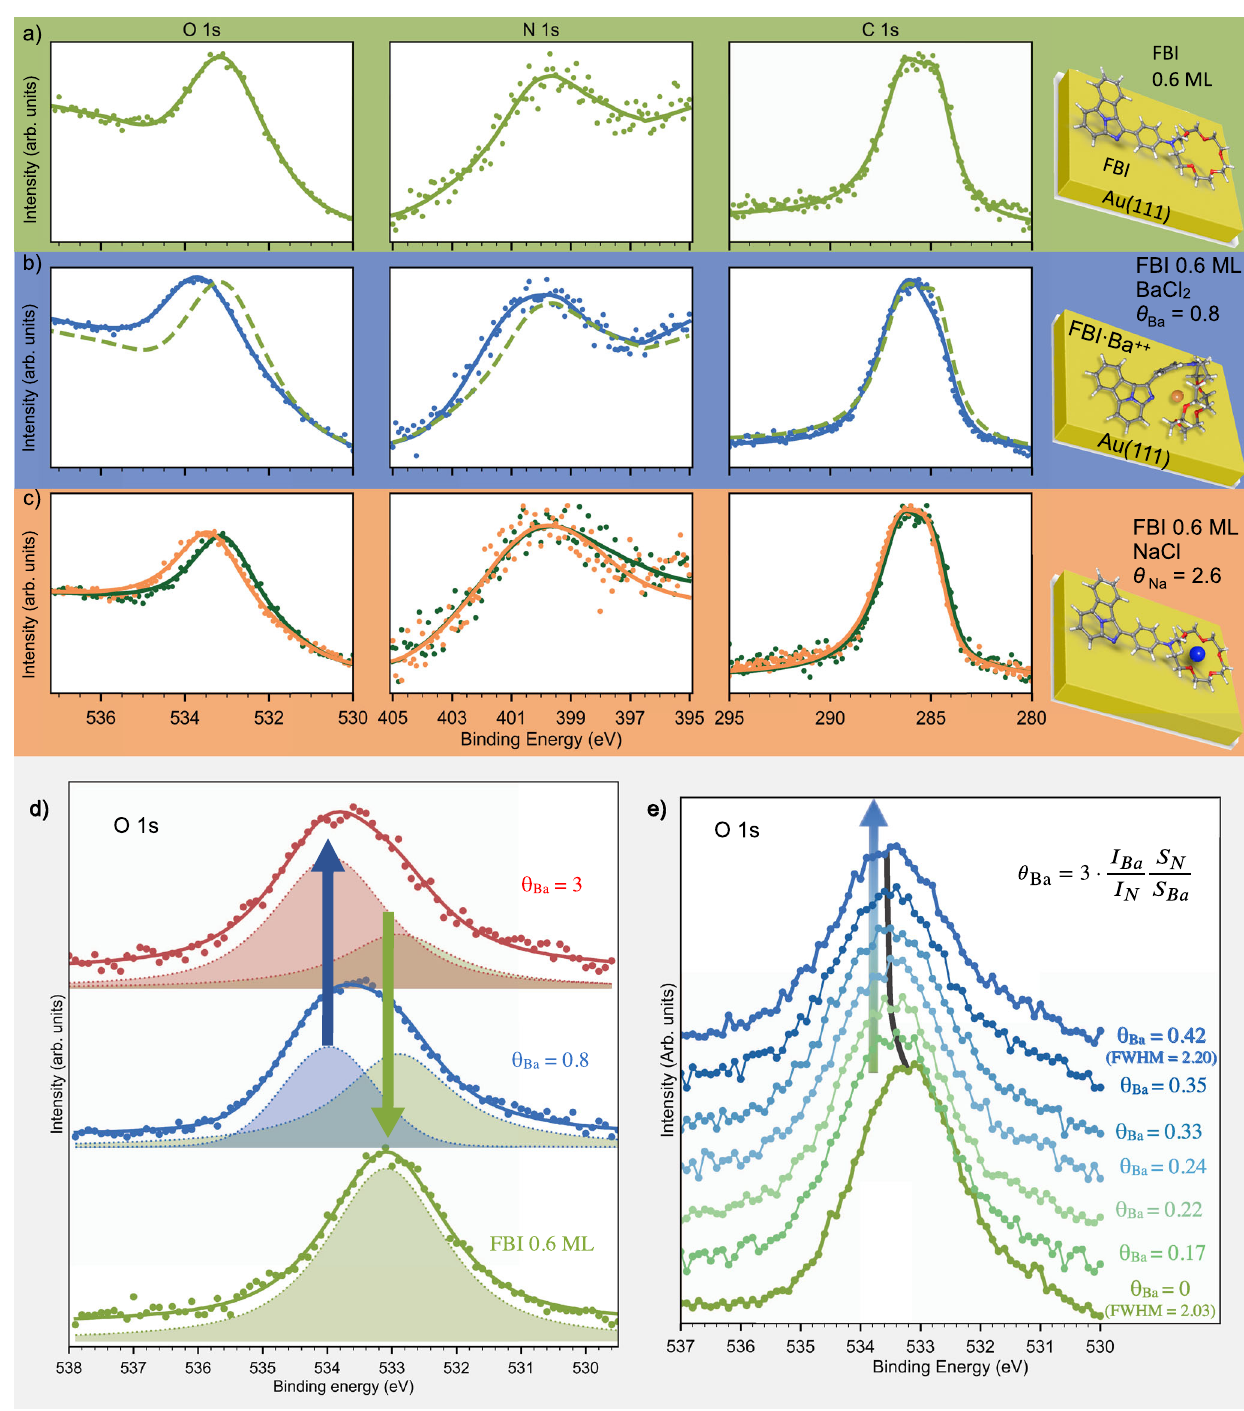
Fig. 2 | XPS demonstration of the chemical changes induced by the molecular chelation.a O1 s ,N1 s ,andC1 s corelevelspectrameasuredaftersublimationof0.6 MLof FBIdepositiononAu(111); b FBIcorelevelspectrameasured onthe previous sample (dashed spectra) after chelation with 0.80 Ba +2 ions per FBI molecule (blue spectra); c O 1 s , N 1 s , and C 1 s core level spectra measured after 0.6 ML of FBI depositedonAu(111)(greenspectra)andafterchelationwithNa + (2.60Na + ionsper FBImolecule)(orangeline).Forthethreepanels,dotscorrespondtorawvaluesand